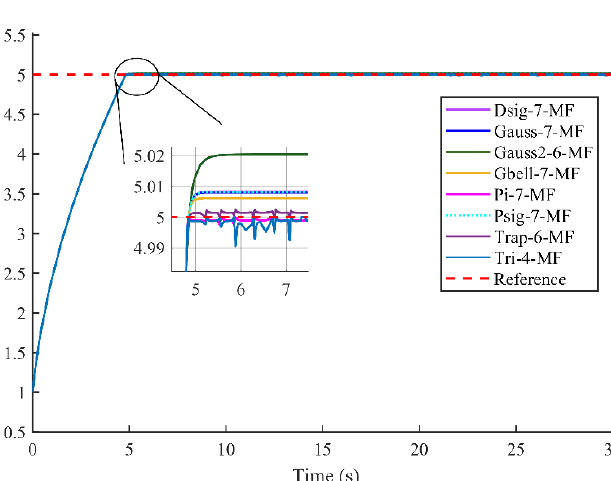
Figure 9. Performance comparison of different MFs.